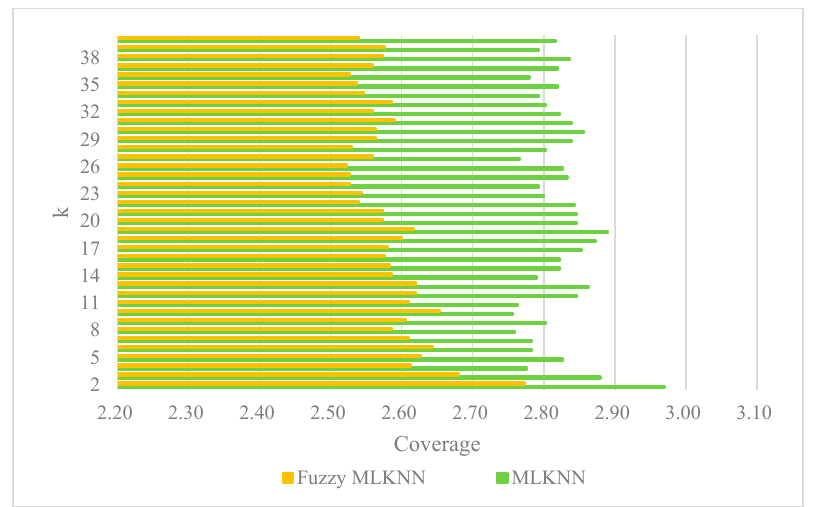
Figure 5. Coverage under different K values.